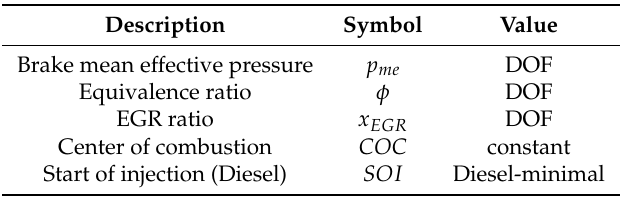
Table 3. Overview of the independent variables.